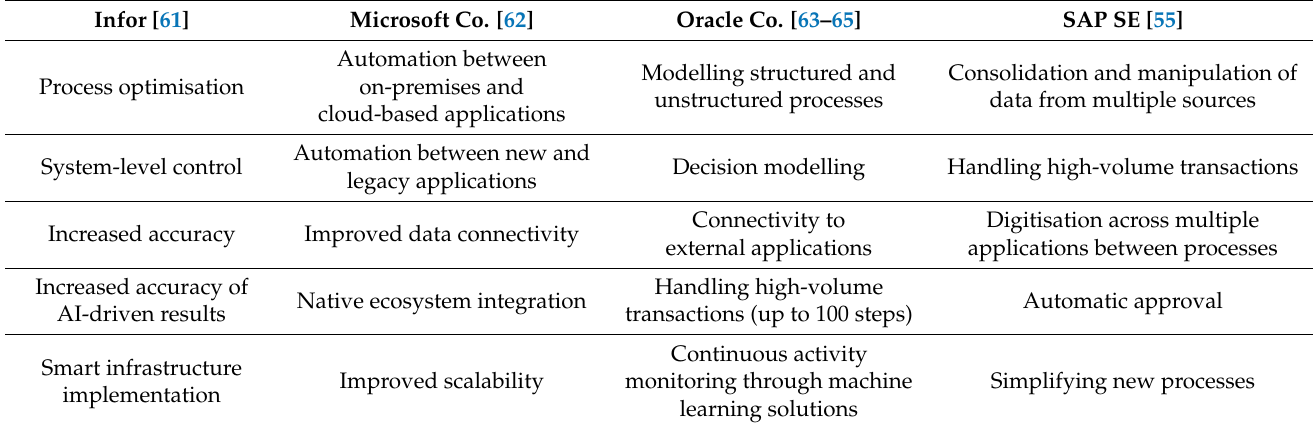
Table 2. Benefits of combining ERP systems with IPA solutions in the context of